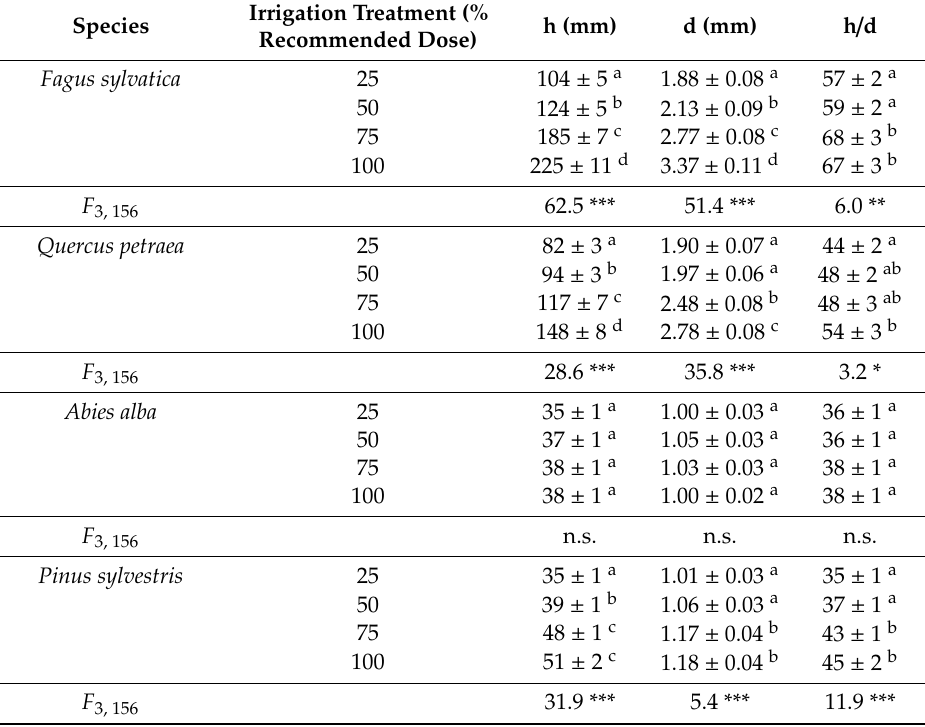
Table 1. E ff ect of irrigation treatments (100%, 75%, 50% or 25% of the recommended dose) on height (h), diameter at root collar (d) and h / d ratio in Fagus sylvatica , Quercus petraea , Abies alba , and Pinus sylvestris seedlings. Means ± S.E. are given ( n = 40). One-way analysis of variance F -values (with degrees of freedom for treatment e ff ect and error term given in subscript) and the associated p values are shown separately for each species (*** p < 0.001, ** p < 0.01, * p < 0.05, n.s.—not significant). Means within column and within species marked by the same letters (a, b, c, d) were not significantly di ff erent. Irrigation Treatment (% h (mm) d (mm) h / Species Recommended Dose)